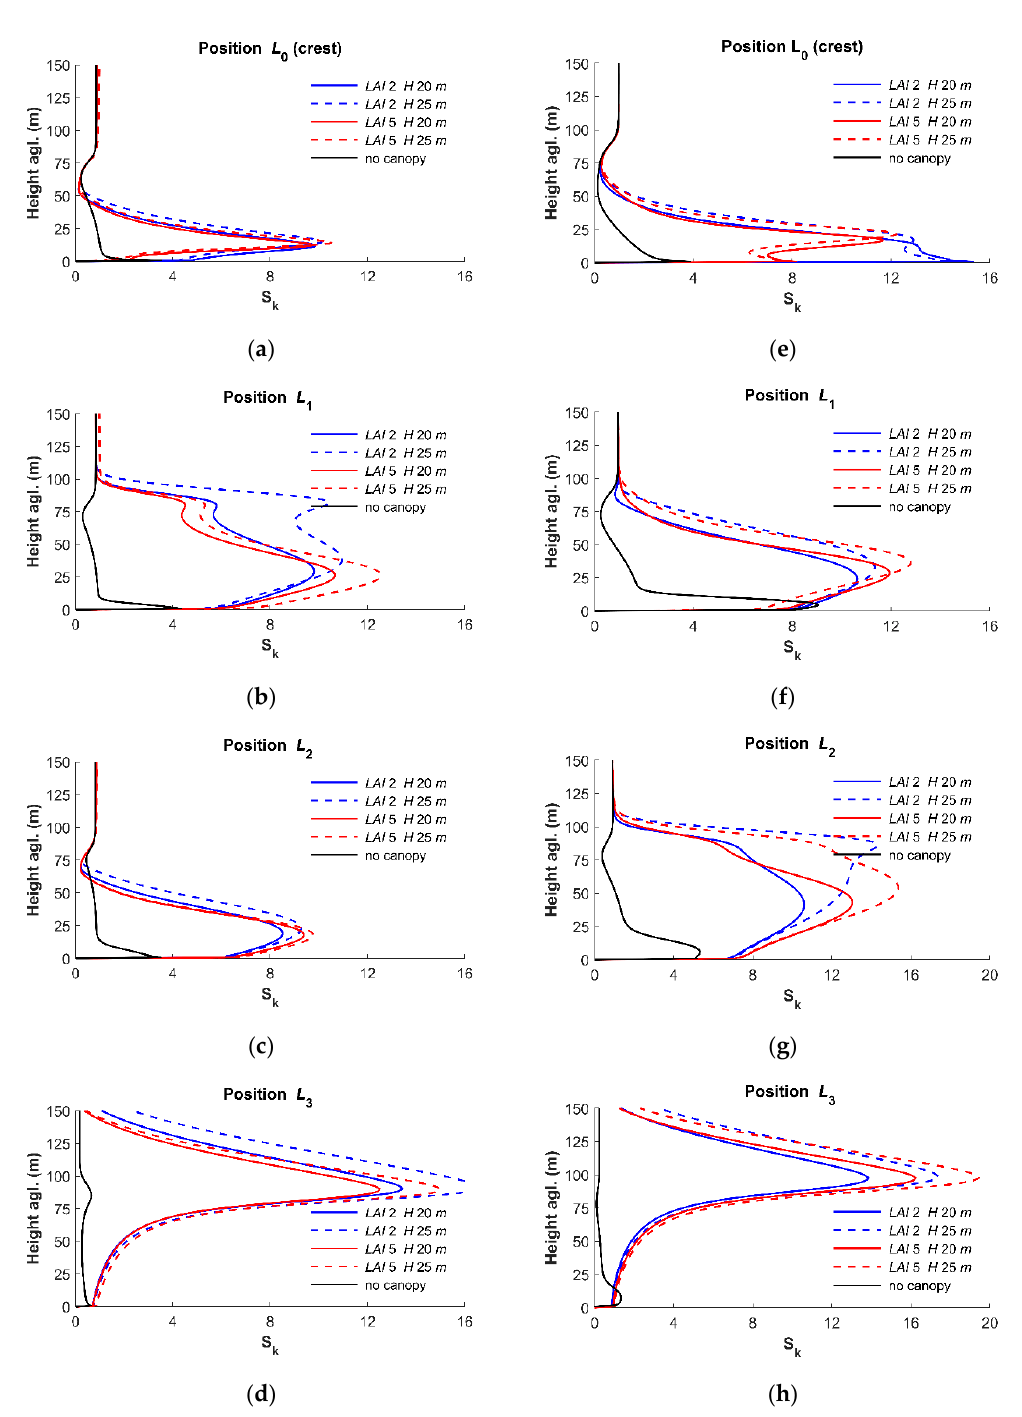
Figure 5. Speed-up profiles of the turbulent kinetic energy at 𝐿 0 , 𝐿 1 , 𝐿 2 , and 𝐿 3 position for an angle of 15 ◦ ( a – d ) and 30 ◦ ( e – h ). The red and blue curves are the simulation results with a LAI of 2 and 5, respectively. The solid and dashed lines indicate a forest height of 20 m and 25 m, respectively.